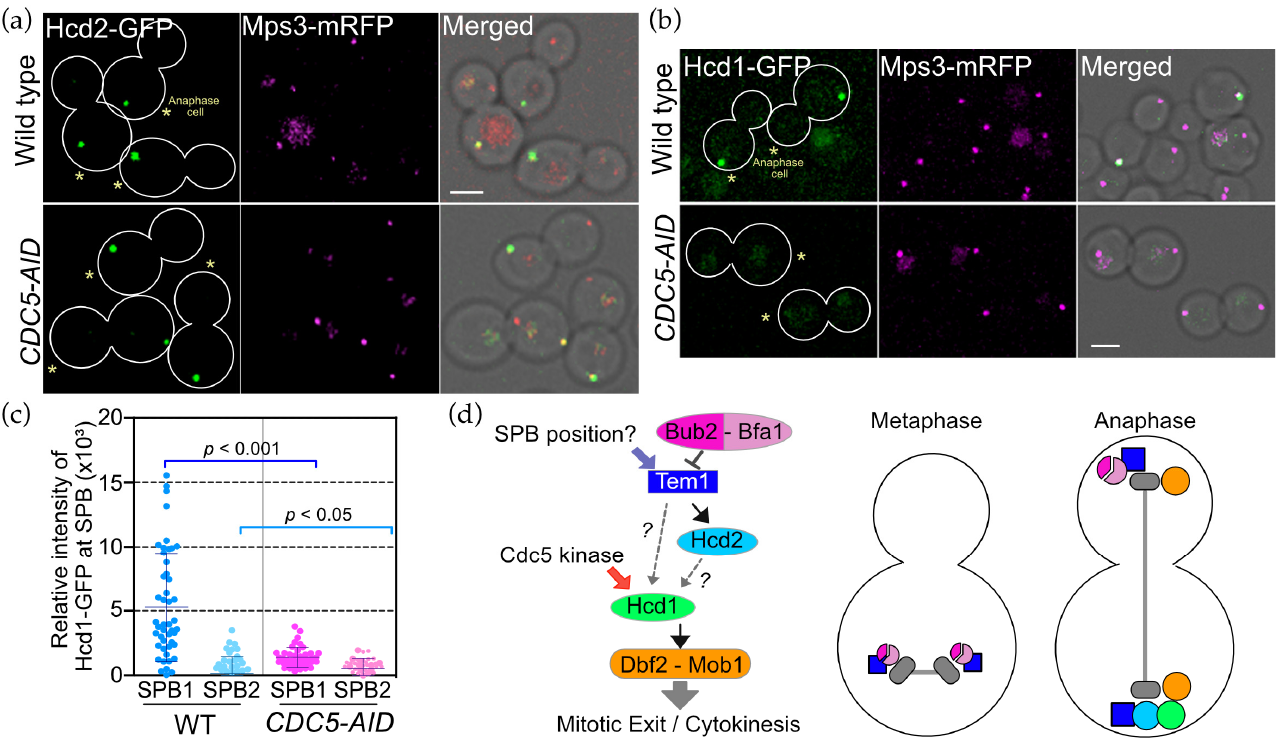
Figure 8. The polo-like kinase is required for SPB binding of OpHcd1. ( a , b ) OpHcd1, but not OpHcd2, required OpCdc5 for SPB localisation in anaphase. Wild type and OpCDC5-AID cells carrying OpHCD2-GFP MPS3-mRFP (HPH1608 and HPH1769), or OpHCD1-GFP MPS3-mRFP (HPH1605 and HPH1768) were grown in YPDS medium at 30 °C. IAA was added to a final concentration of 500 µM and incubated for 2 h before capturing images by microscopy. Mps3-mRFP is a marker for the SPB. Shown are deconvolved and projected GFP and RFP images, and merged brightfield, GFP, and RFP images. Scale bar, 2 µm. ( c ) Intensity measurement of GFP at the SPB of anaphase cells in b. The SPB carrying the stronger GFP signal was designated as SPB1 and the other one as SPB2. In total, 48 wild type cells and 41 OpCDC5-AID cells were analysed. Statistical significance was determined by the t -test. ( d ) Model of the ME-signalling pathway in O. polymorpha . See the Discussion for details.